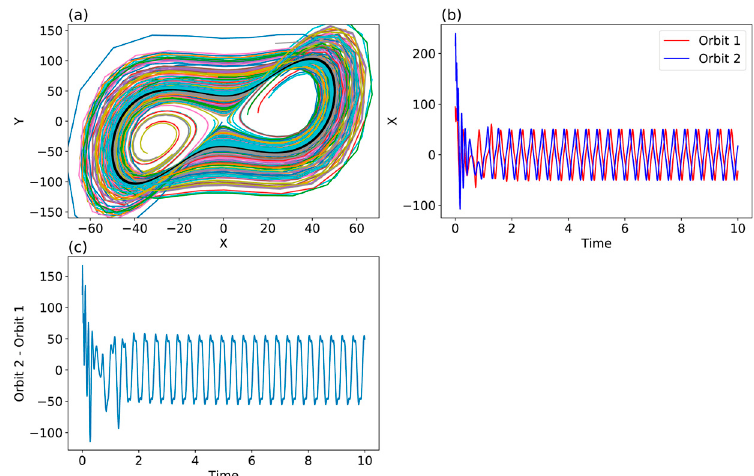
Figure 3. ( a ) A limit cycle (black) as indicated by the convergence of 200 orbits (color) beginning with 200 different initial conditions for r = 350 within the 3DLM. Color lines depict orbits during the period of τ = 1 and τ = 10 (i.e., τ ∈ [1 , 10]). “A thick black line” displays 200 orbits for τ ∈ [9 , 10]. Convergence of the 200 orbits into the black orbit indicates the isolated nature of a limit cycle. Panels ( b ) and ( c ) display two orbits and their differences, respectively.